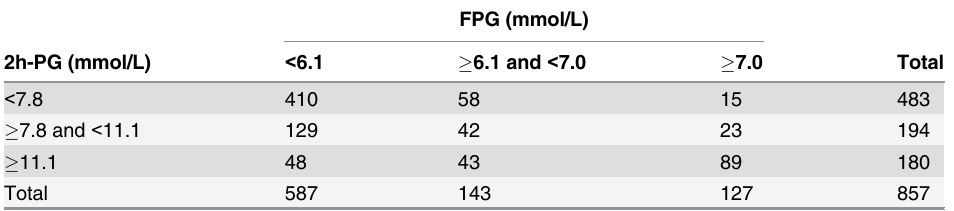
Table 2. Number of subjects according to the categorization of glycemic status using FPG and 2h-PG based on the 1999 WHO diagnostic